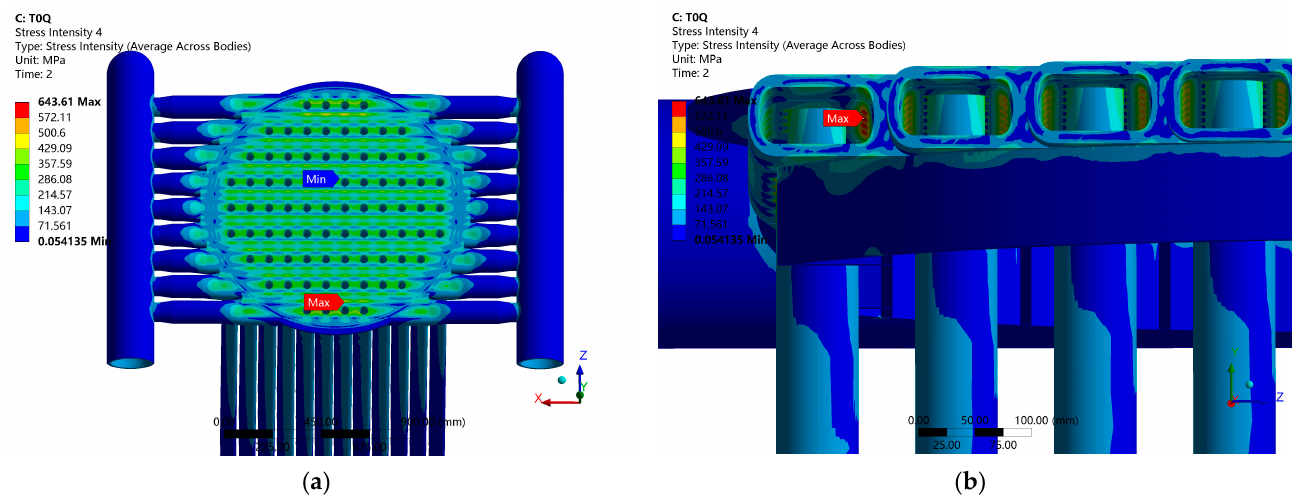
Figure 5. ( a ) Stress intensity distribution and ( b ) maximum stress on the upper flat-round tubesheet under load case 2 without prestretching of the tubes.